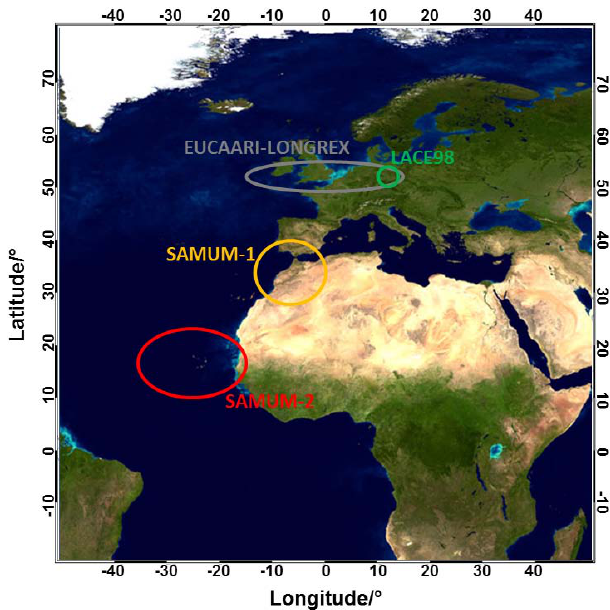
Fig. 1. Main measurement areas of the four considered field exper- iments on underlying Blue Marble monthly global images for July from NASA’s Earth observatory (http://earthobservatory.nasa.gov/